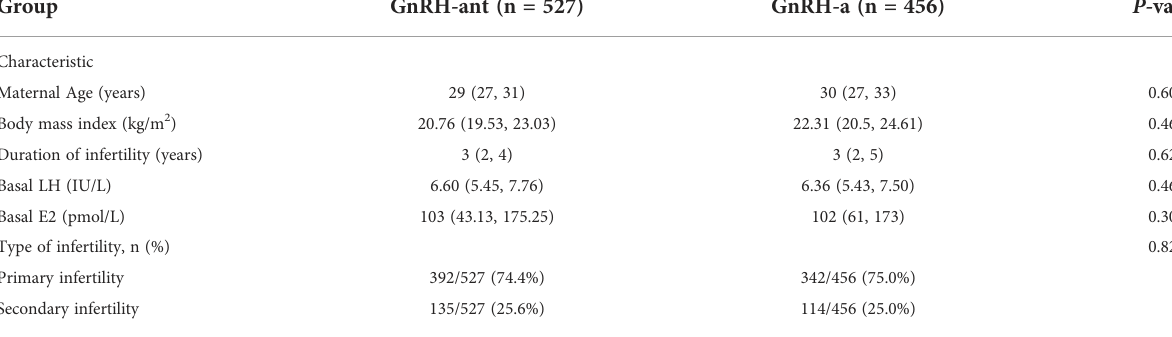
TABLE 1 Clinical features of patients in different ovarian stimulation groups.